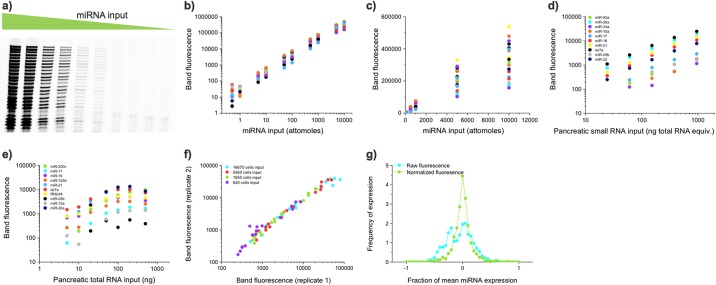
Ligo-miR EZ sensitivity and reproducibility data.a) A PAGE image of Ligo-miR EZ products from a 26-plex serial dilution of synthetic miRNAs from 10,000 attomoles to 0.5 attomoles. Data from 3 miRs with higher sensitivity cutoffs are omitted. Raw band fluorescent intensities are tabulated in S1 File, Table S1. b) Image analysis of the fluorescent band intensities. Some plateauing of the assay can be seen at the highest input level. Below this, the assay shows a linear response over 4 orders of magnitude for 12 of the 22 miRNAs (not counting Crc-1,2,3 or 4) the lowest point is missing or an outlier for 3 miRs, giving a measured dynamic range of 3.5 orders of magnitude. The lowest dynamic range is for RNU6B, we suspect because of an outlier measurement, and is only 1.5 orders of magnitude. The mean dynamic range is 3.5, the median dynamic range is 4 and the mode dynamic range is 4 orders of magnitude. c) Same data as shown in b) but plotted on linear-linear axes. d) Ligo-miR EZ was performed on a dilution series of small RNA fractions isolated from pancreatic total RNA. A linear response was seen up 1000 ng of total RNA equivalent input. e) When total RNA is input directly, a linear response is seen up until 100 ng at which point background RNA begins inhibiting ligation efficiency. f) Replicate experiments were performed on 4 samples of small RNA isolated from 600–17000 cultured cells and plotted against one another. High correlation was seen between replicate experiments across all input levels. g) Ligo-miR EZ was repeated 28 times on a 26-plex synthetic miRNA panel over a period of 3 months. The distribution of raw fluorescence values as a fraction of the mean is centered around zero with a side peak at -0.2. When the raw fluorescence values are corrected for scanner variability, the data have a very sharp distribution centered around the mean.